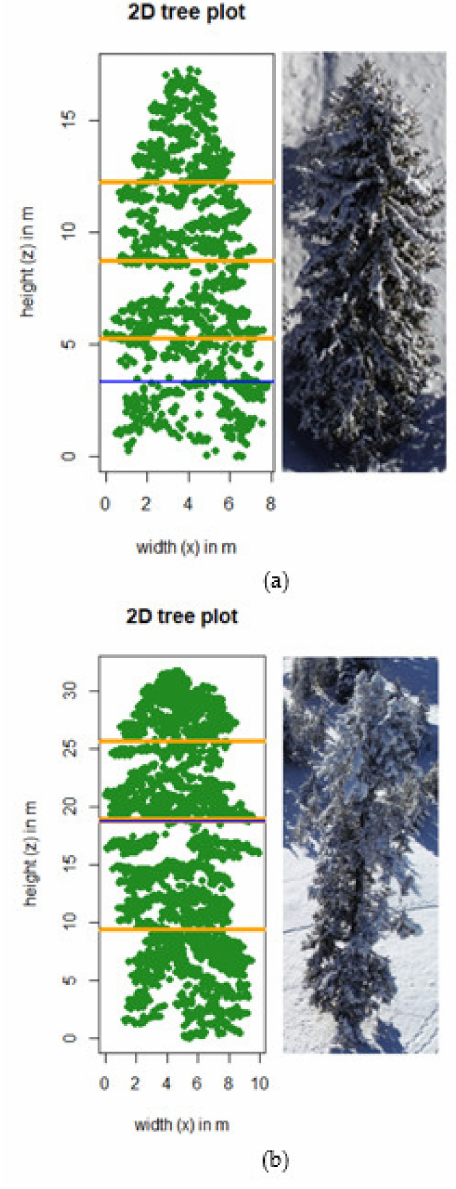
Figure 7. Two-dimensional tree plot of x and z coordinates with 25%, 50%, and 75% quartiles in orange and canopy length in light blue; unmanned aerial system image of corresponding trees from Dec. 5, 2018. Tree #3 ( a ) was 31.7 m and averaged 1.25 m 3 intercepted snow volume; Tree #4 ( b ) was 17.3 m and averaged 1.89 m 3 intercepted snow